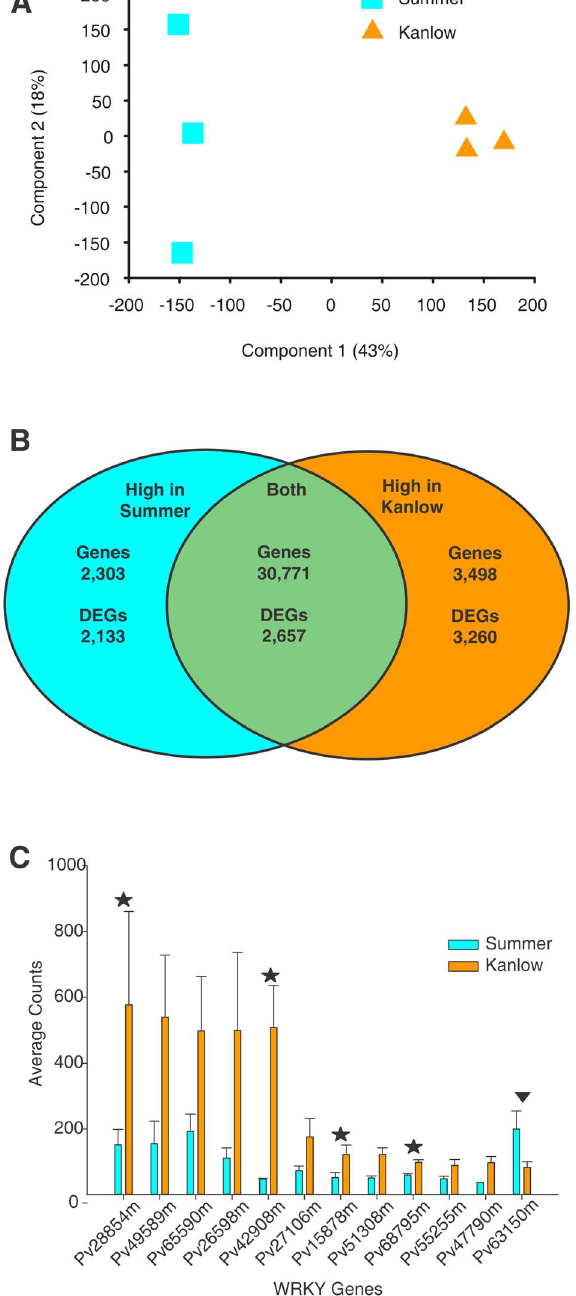
Figure 1. Transcriptomes of Kanlow and Summer plants are different, and show differential enrichment in WRKY genes. ( A ) PCA of transcriptomes of the three biological replicates obtained from each ecotype. Kanlow (orange triangle) were differentiated from Summer (cyan squares) by the first component. ( B ) Venn diagram of numbers of common and highly expressed genes in Summer (log 2 FC , -1) and Kanlow (log 2 FC . 1), including DEGs in the Kanlow (orange) and Summer (cyan) datasets. ( C ) Mean counts for twelve transcripts identified as WRKY transcription factors. Stars above orange bars (Kanlow) identify putative switchgrass orthologs of WRKY factors involved in defense response in other systems. The inverted triangle over a cyan bar identifies a WRKY ortholog to an Arabidopsis gene involved in senescence that is upregulated in Summer crowns and